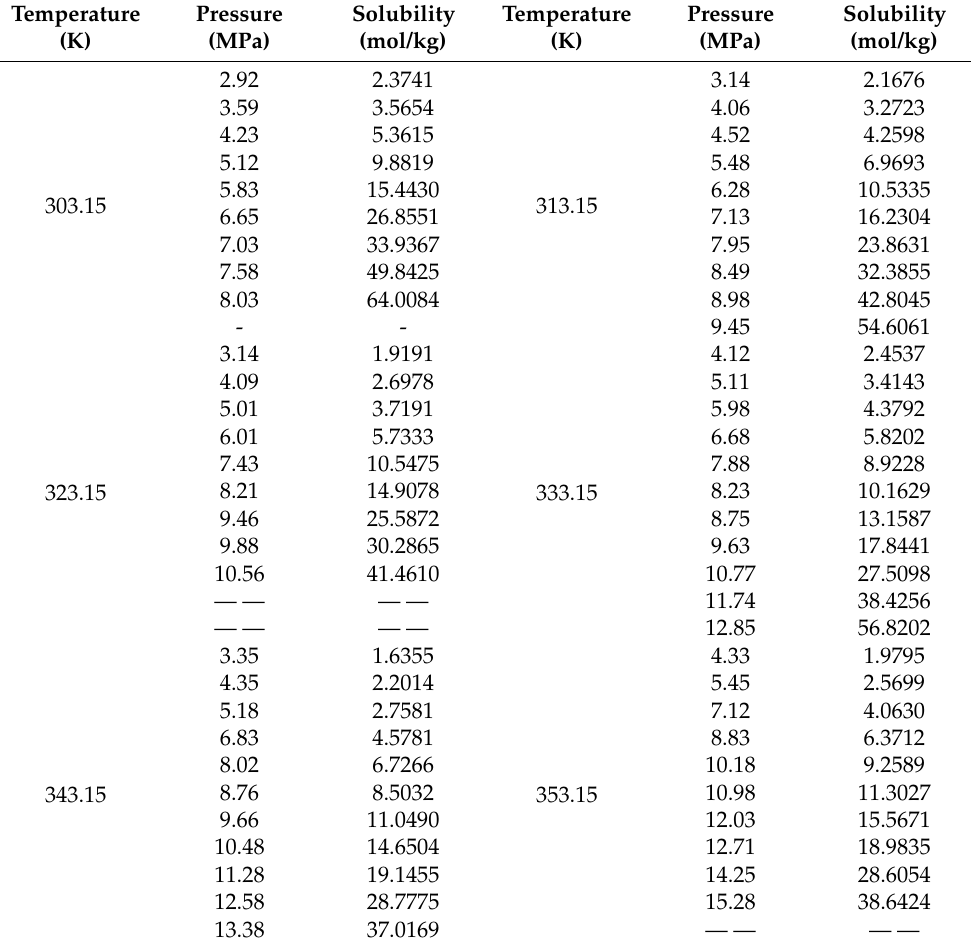
Table 7. The solubility of CO 2 + n -decane system at 303.15~353.15 K and 0~15 MPa.